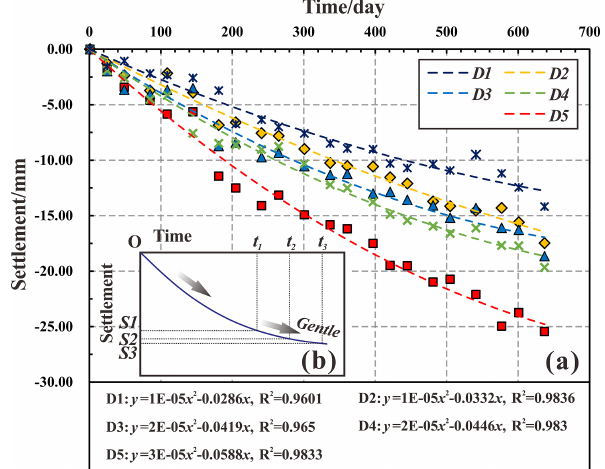
Figure 6. (a) Vertical displacement time-series of the ground, as measured from February 2011 to October 2018. (b) Diagram of the Selection of ( S i , t i ) on Settlement-Time